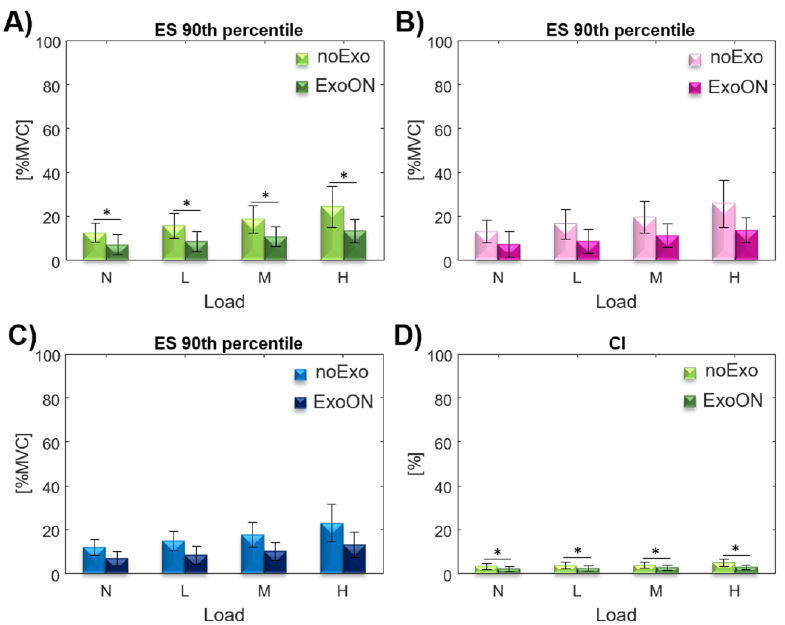
Figure 6. 90th percentile for the ES muscular activation, with and without the exoskeleton, at 30 ◦ inclination and for four load conditions for the whole population ( A ), the female population ( B ), and the male ( C ) population. ( D ) CI with and without the exoskeleton in the four load conditions.